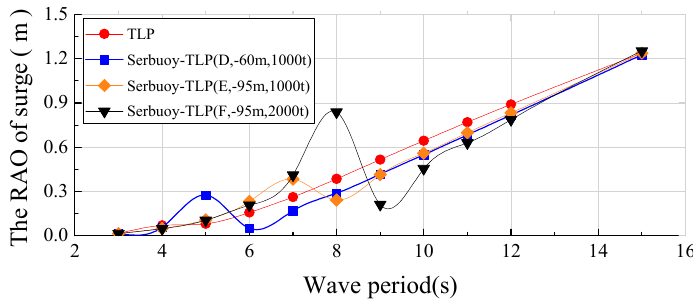
Figure 8. Surge contrast of TLP and Serbuoys-TLP under working conditions D, E and F.